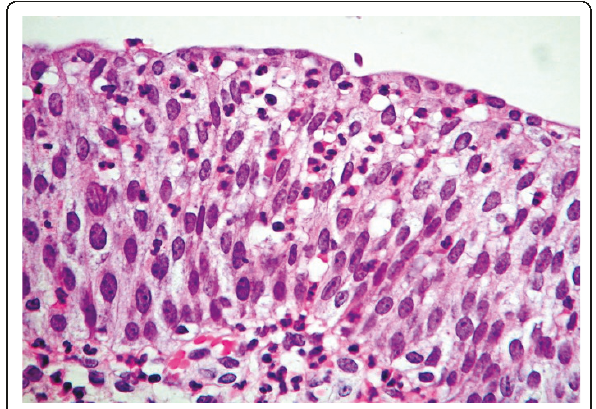
Figure 3 Reactive atypia